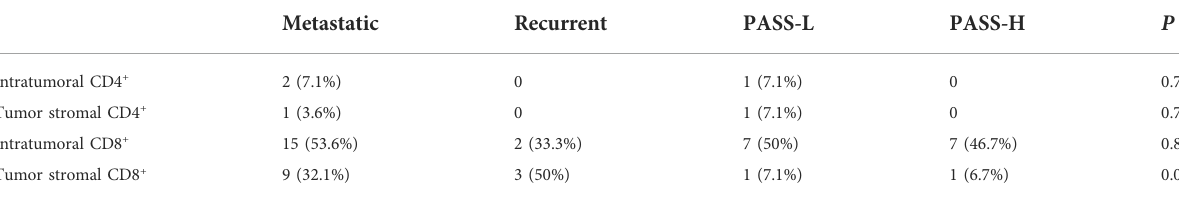
TABLE 4 Case numbers and percentages of intratumoral and stromal CD4 + and CD8 + lymphocytes in fi ltration in. Pheochromocytoma and paragangliomawithdifferentdegreesofmalignancy.IntratumoralandstromalCD4 + andCD8 + lymphocytesin fi ltrationinmetastaticandprimary